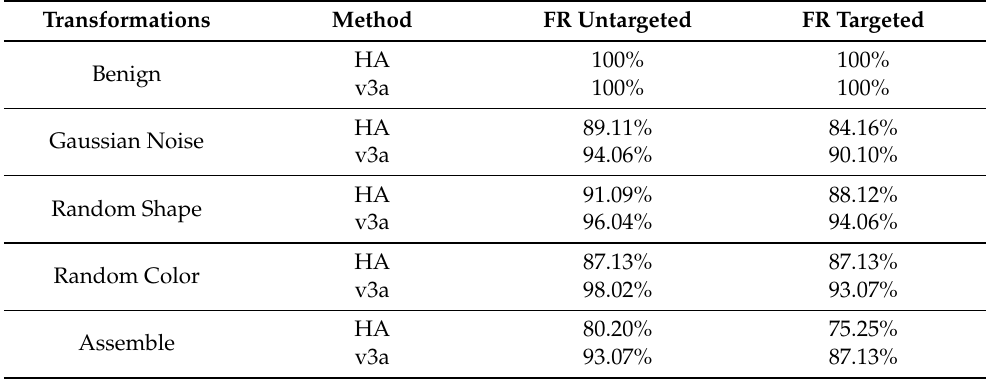
Table 2. Black-box attacks against the LRCN model. The MAP of HA and our method are 1.4528 and 1.4991,